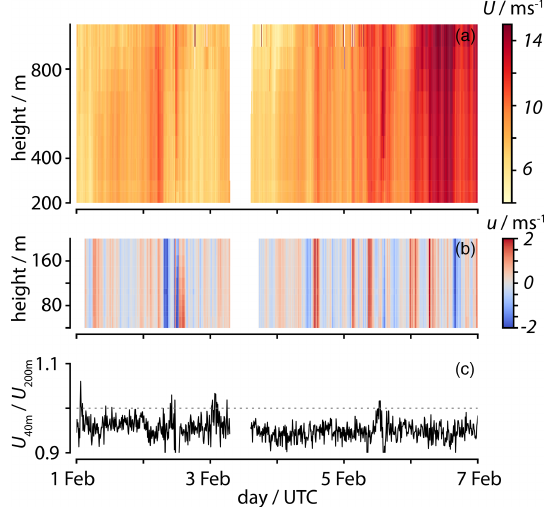
Figure 14. Sub-cloud layer lidar wind versus height above the R/V Meteor . Panel (a) shows the value of the wind speed in the sub- cloud layer, above 200m. Fluctuations of the near-surface wind speed from a 3-hourly running mean value (b) are shown with an expanded vertical scale. The lower time series (c) shows the ratio of the wind speed at 40m (the lowest remotely sensed level) to its value at 200m.